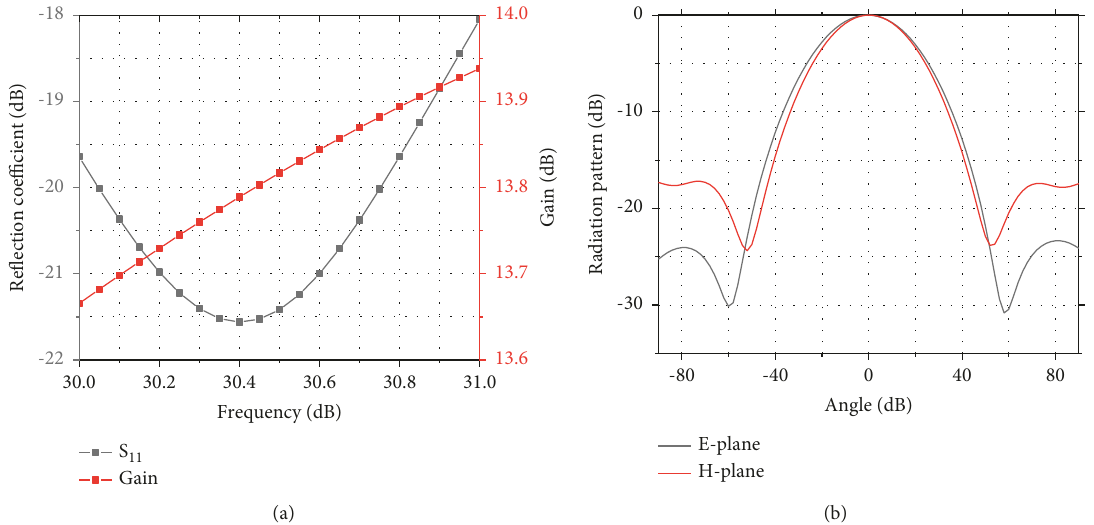
Figure 2: Simulated (a) |S 11 |, gain, and (b) radiation patterns of the subarray.